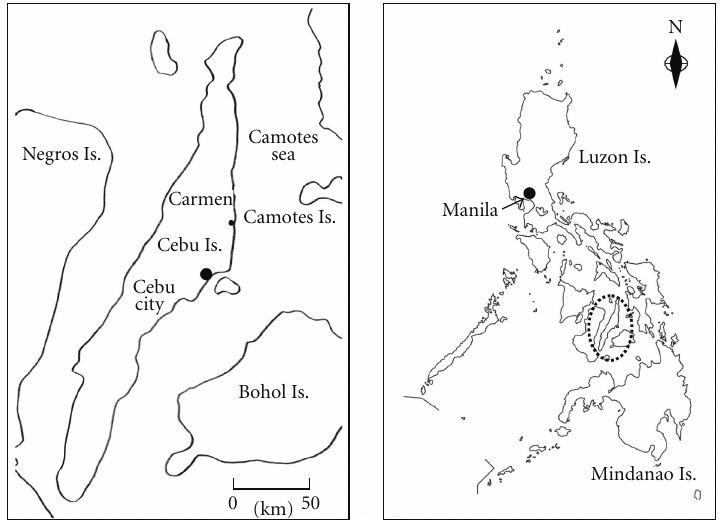
Figure 1: Map showing crab-collecting locations in Cebu Island. The location of Cebu Island in the Philippines is shown in the map to the right. The map on left shows an enlarged image of Cebu Island to pinpoint the sampling location.